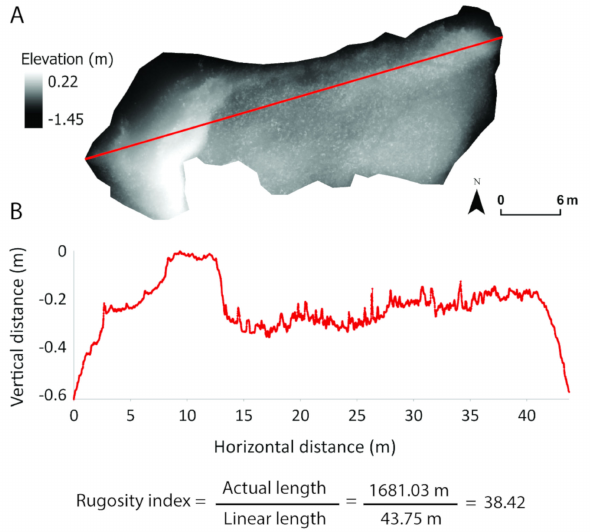
Figure 4. Digital chain-and-tape method to calculate an intertidal oyster rugosity index which can be calculated by dividing the actual length ( B ) from the linear length ( A